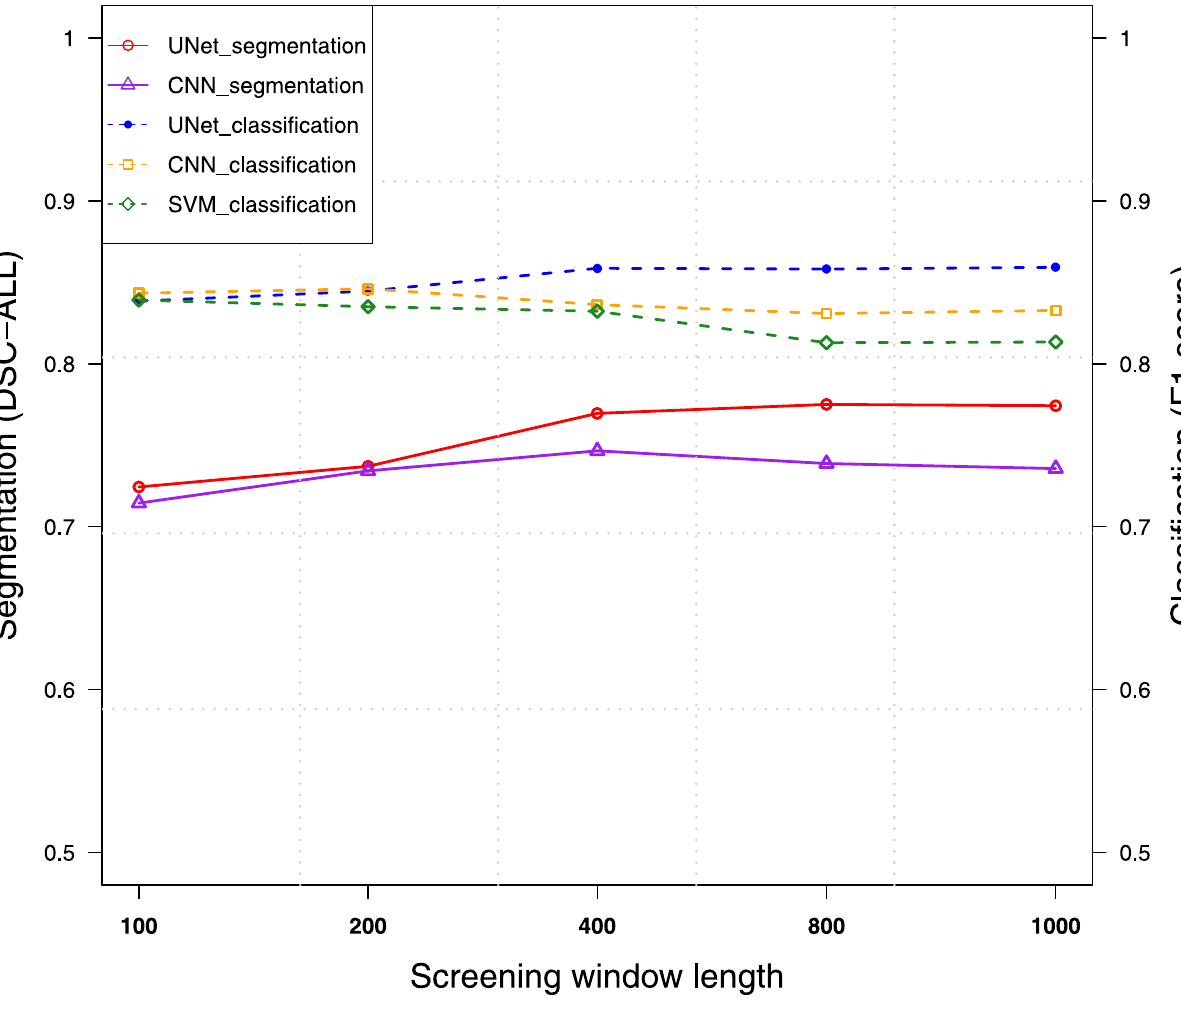
Fig 6. Performance of models using different screening window lengths on NA12878 WGS data of 60x read depth. The dashed curves connect F1 scores of classification, while the line curves show DSC-ALL scores of segmentation.